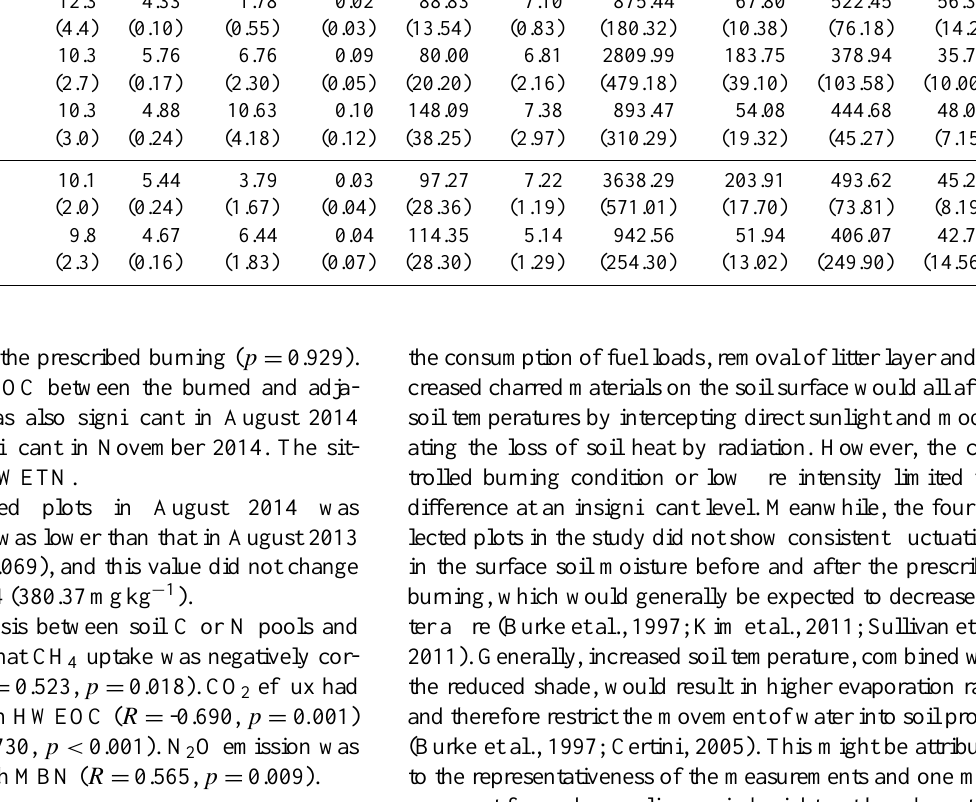
Table 3. Surface soil properties in Toohey Forest before and after the prescribed burning. Values in parentheses indicate standard errors for the four replicate plots of each sampling period. Soil moisture is presented in %. Other parameters (except pH) are presented in mgkg − 1 .